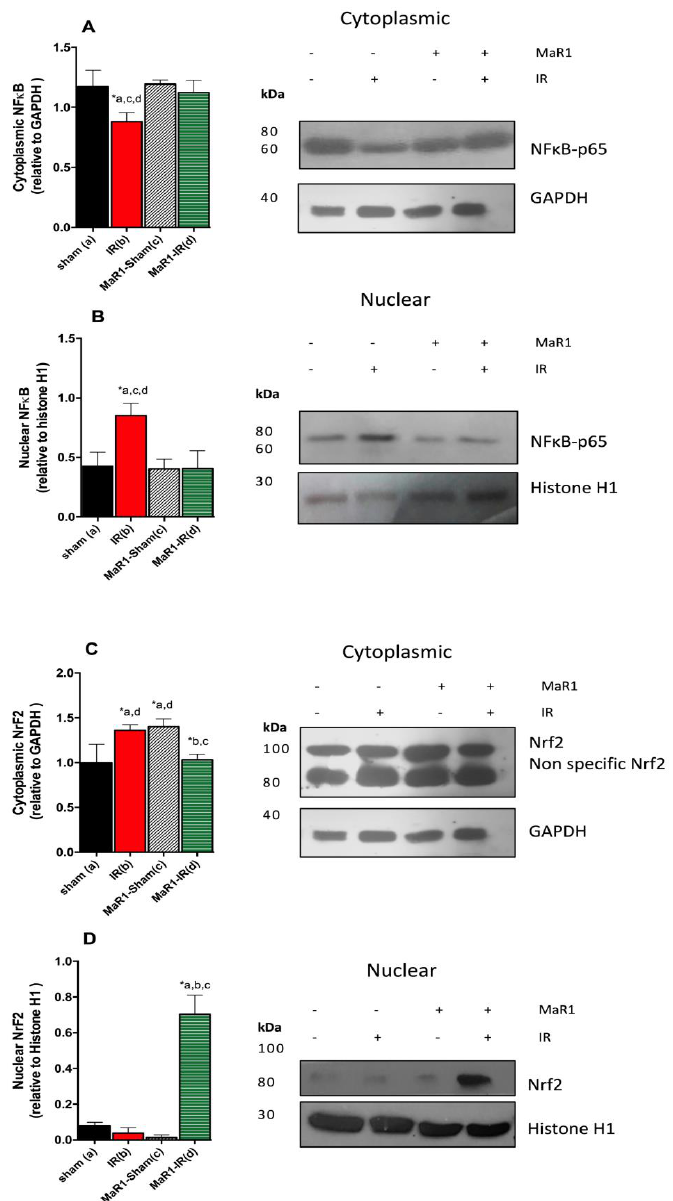
Figure 7. E ff ect of MaR1 on tissue levels of Nrf-2 and NF- κ B after IR. ( A , B ) represents results cytoplasmic Figure 7. Effect of MaR1 on tissue levels of Nrf-2 and NF-κB after IR. ( A , B ) represents results cytoplasmic and nuclear levels of NF-κB transcription factor. ( C , D ) represents cytoplasmic and and nuclear levels of NF- κ B transcription factor. ( C , D ) represents cytoplasmic and nuclear levels of Nrf-2 transcription factor. The cytoplasmic levels were quantified relative to GAPDH as housekeeping and nuclear levels were quantified relative to histone H1 as housekeeping. n = 9 rats per experimental group. Asterisk indicates p < 0.05, and the letters identify the experiments that are compared and present this statistical di ff